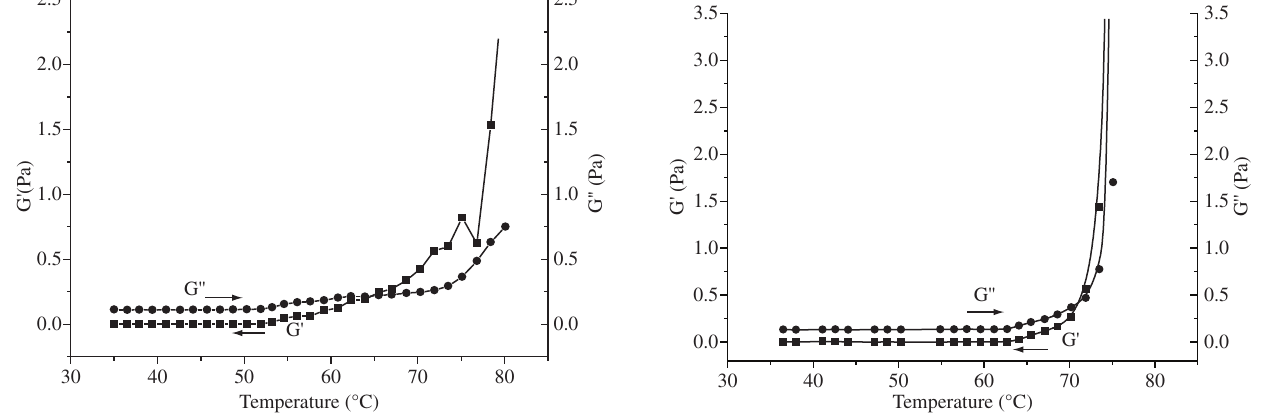
Figure 3. Rheograms showing the elastic (G’) and viscous (G”) moduli of the suspension with 7 wt. (%) albumin, as a function of